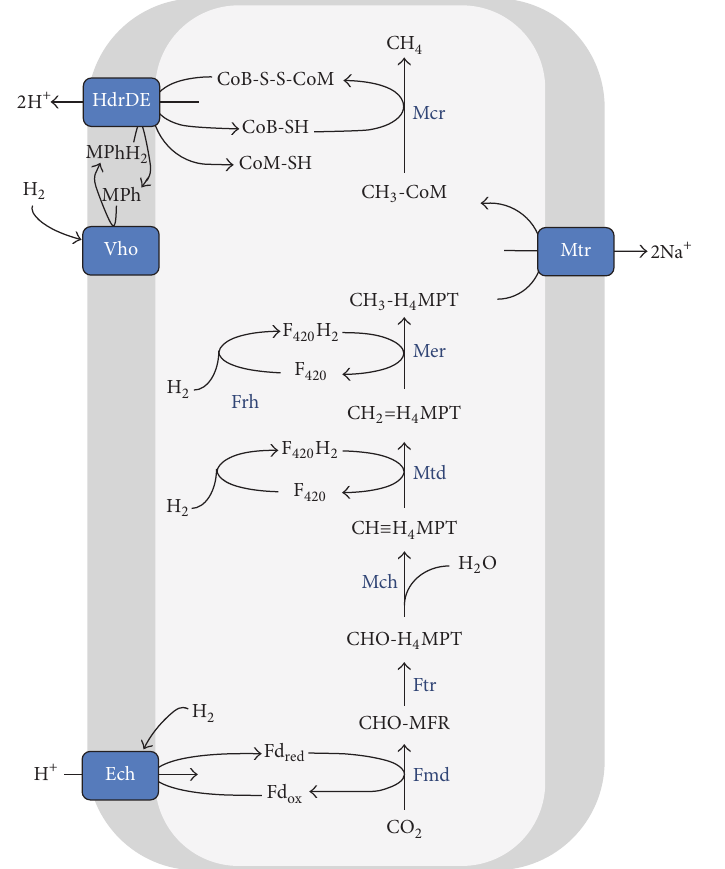
Figure 2: Hydrogenotrophic methanogenesis in cytochrome containing Methanosarcina barkeri . Black lines represent presence of conversions. See Table 3 for